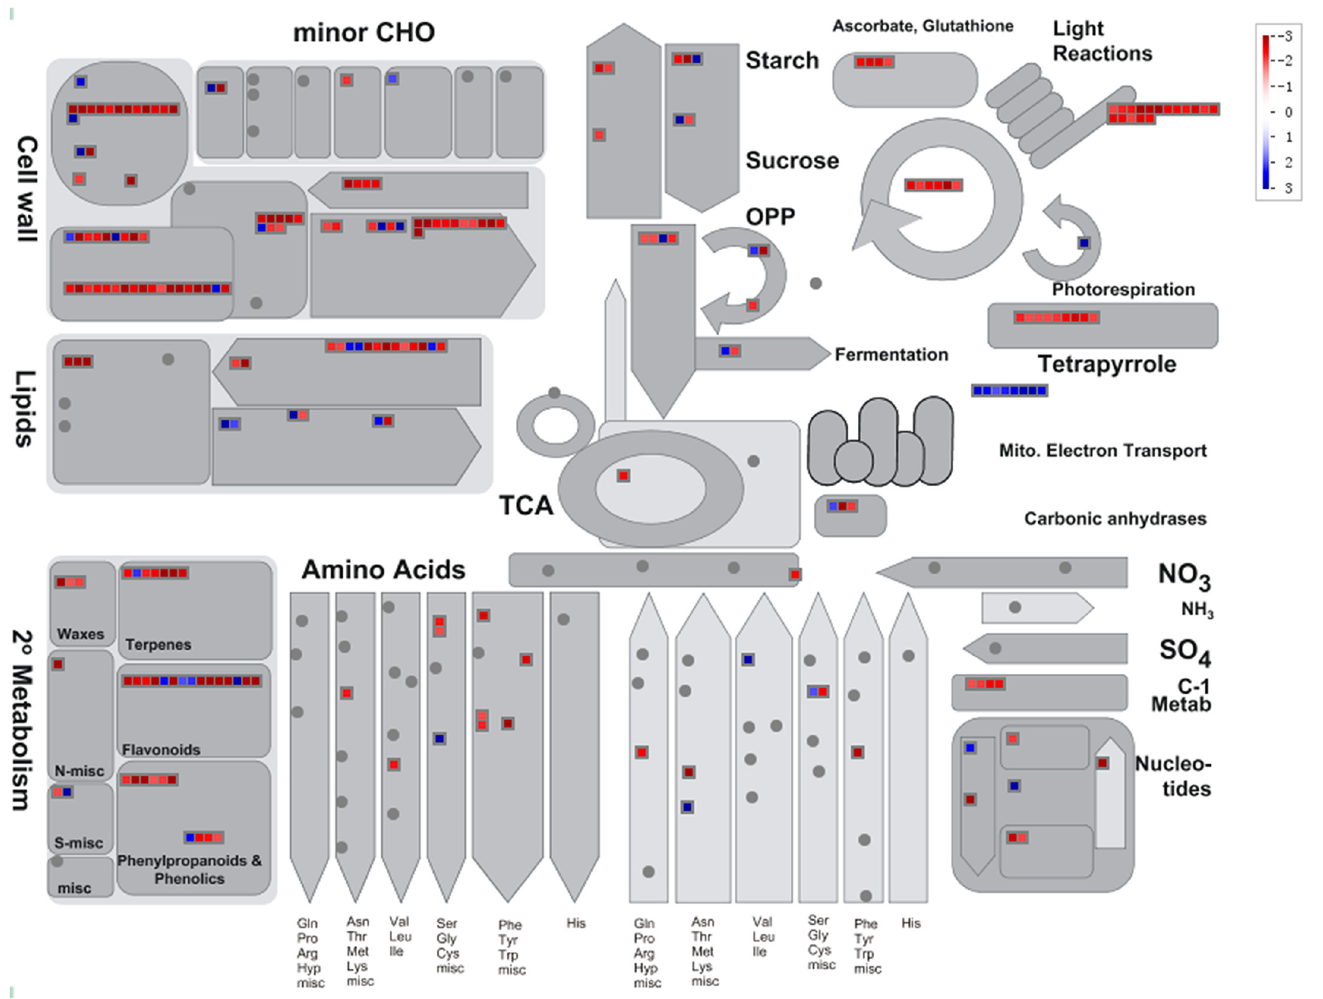
Fig 10. Metabolism overview of genes differentially expressed in VFP3 RNAi-1 plants. The analysis employed the MapMan software. Values are log2 fold changes between the analyzed plants. Blue indicates up-regulation in gene expression, and red indicates down-regulation in gene expression.